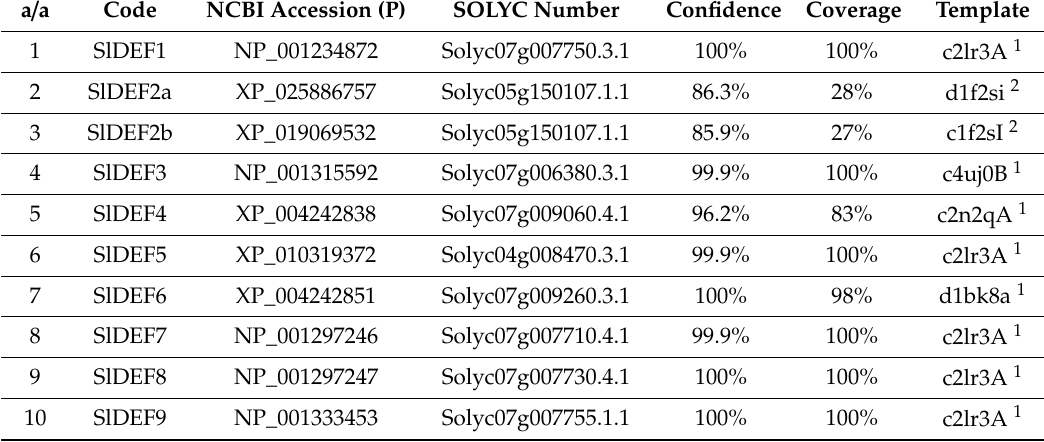
Table 2. 3D structure prediction using the Phyre2 homology protein modeling.